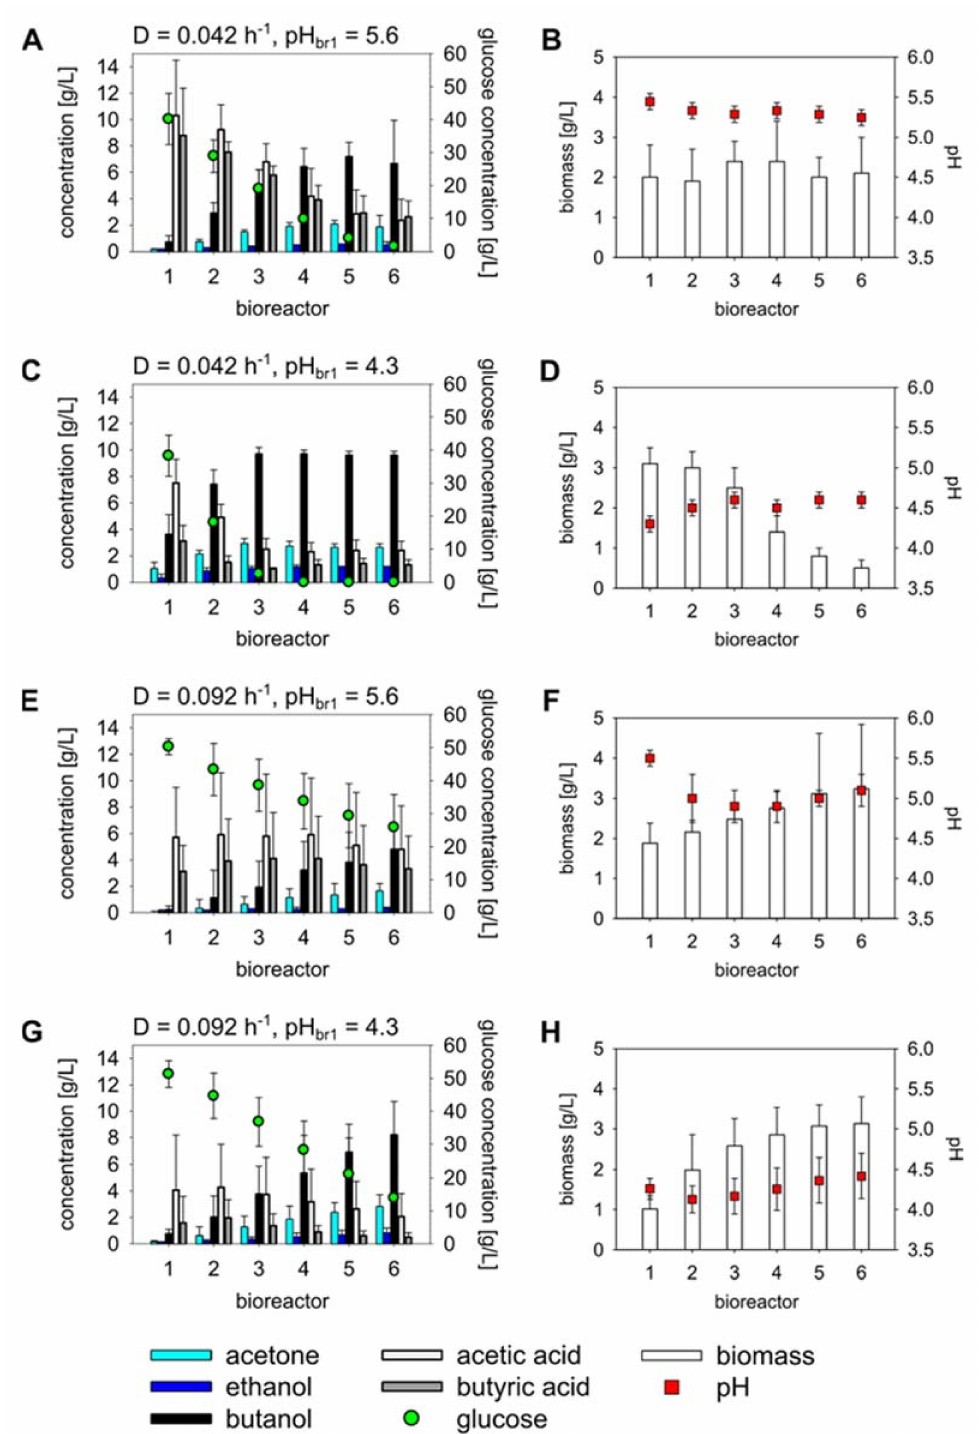
Figure 3. Steady states observed in the six-stage bioreactor cascade under 4 different operating conditions. Data represent means and experimental errors (maximum of standard deviations of individual or averaged data sets) of at least two independently observed steady states under the same operating conditions. For an overview of the individually observed steady states see Table S2a. Operating condition D = 0.042 h − 1 / pH br1 = 5.6; ( A ) Substrate and metabolites; ( B ) pH and biomass